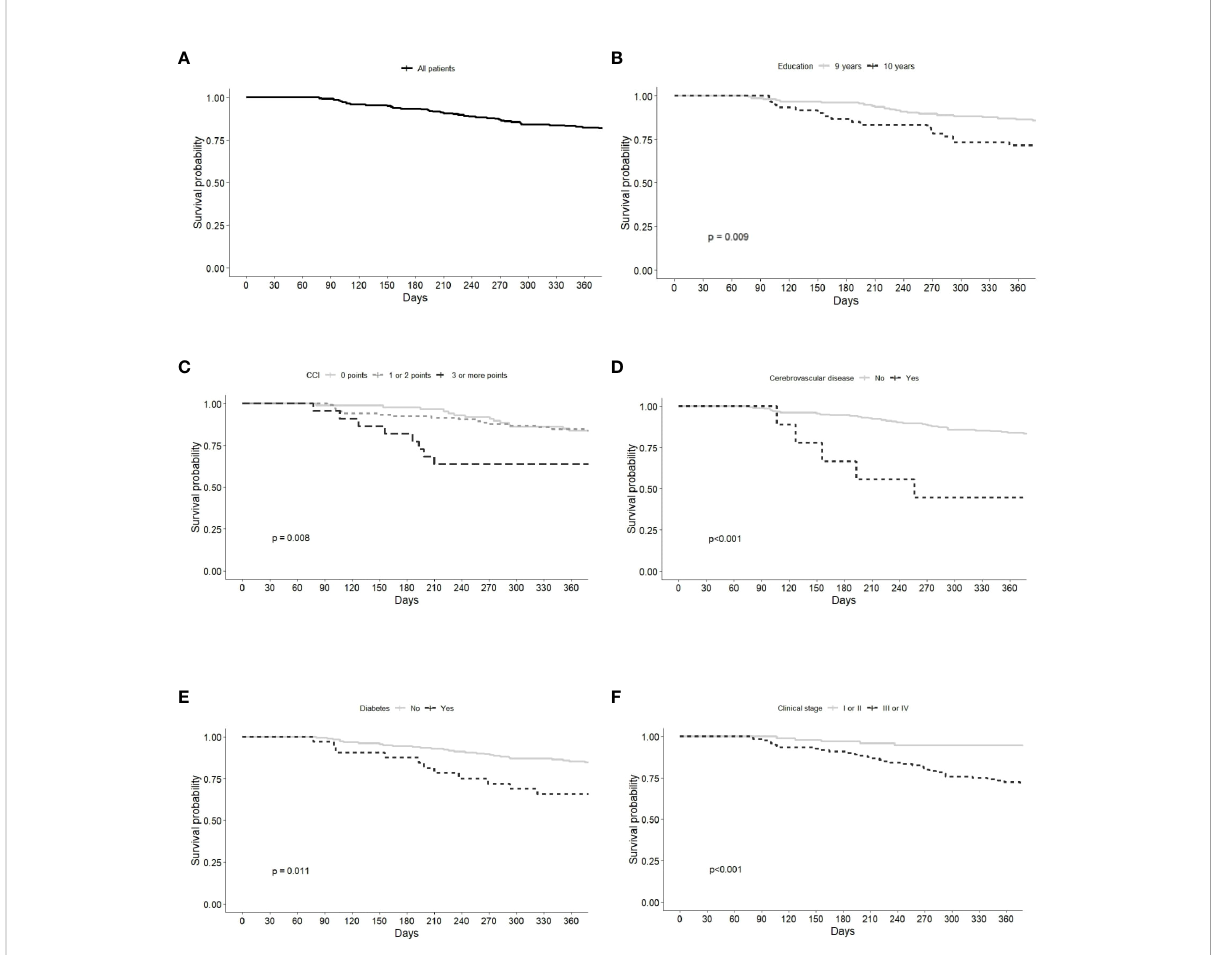
FIGURE 2 Kaplan-Meier survival curves of Gastric Adenocarcinoma patients grouped by (A) all patients, (B) education, (C) Charlson Comorbidity index (CCI), (D) cerebrovascular disease, (E) diabetes, (F) clinical